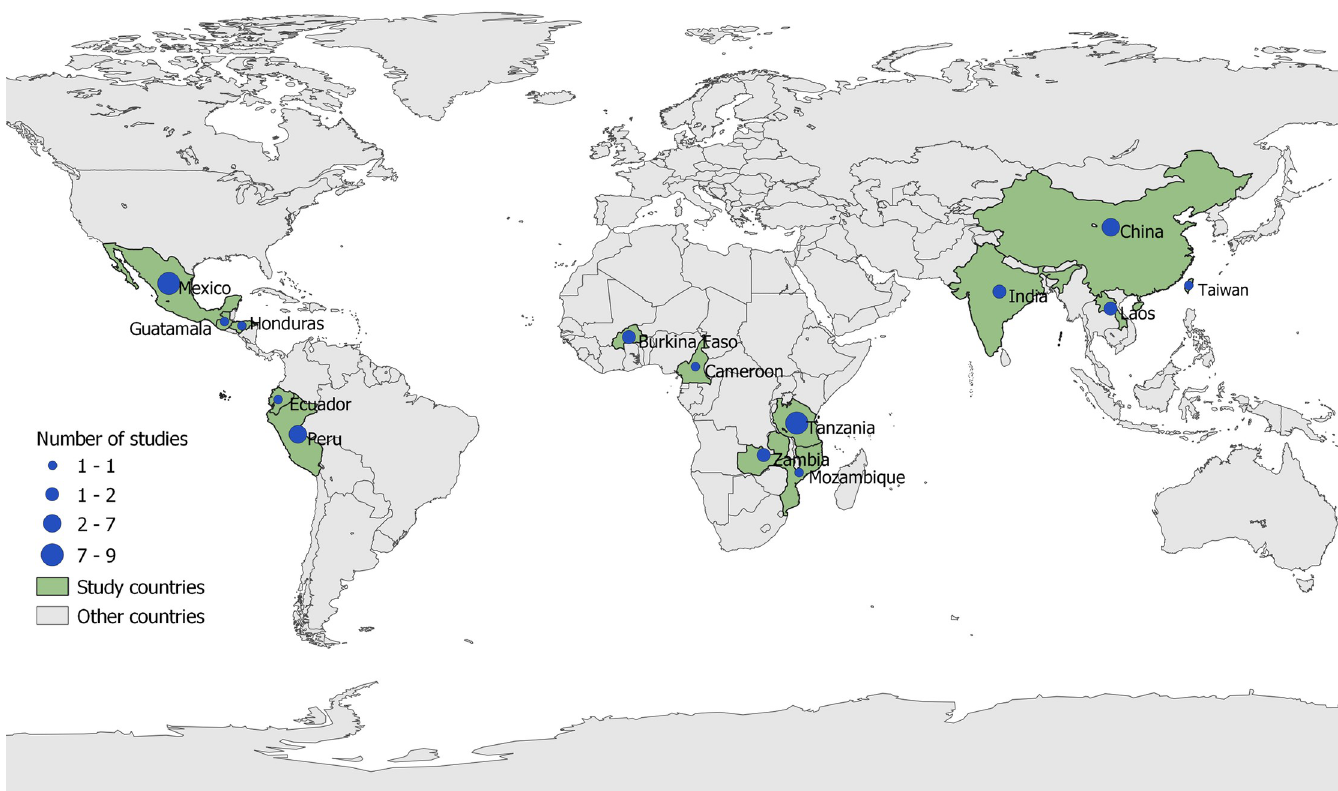
Fig 2. Distribution of studies included in the SLR on contextual factors for T . solium control (Map: Fredrick Otieno, ILRI). Base map Link: http://www. geoboundaries.org